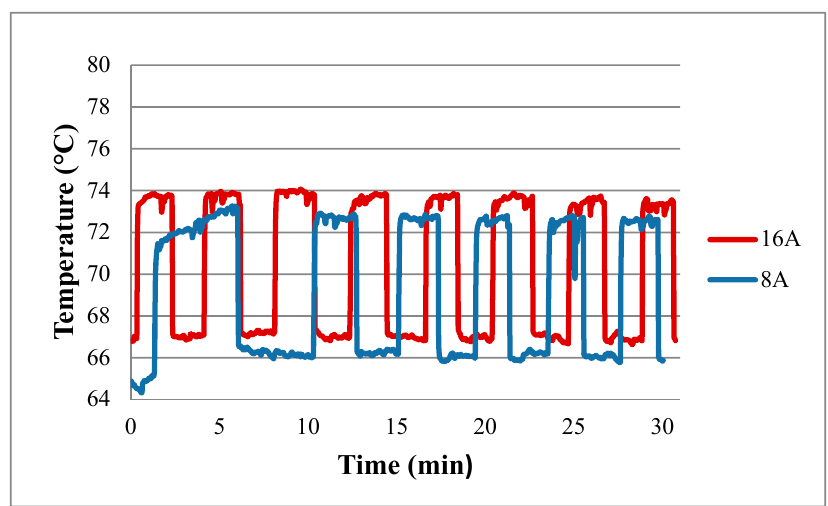
Figure 12. Performance curve of a fuel cell embedded with the flexible four-in-one microsensor.